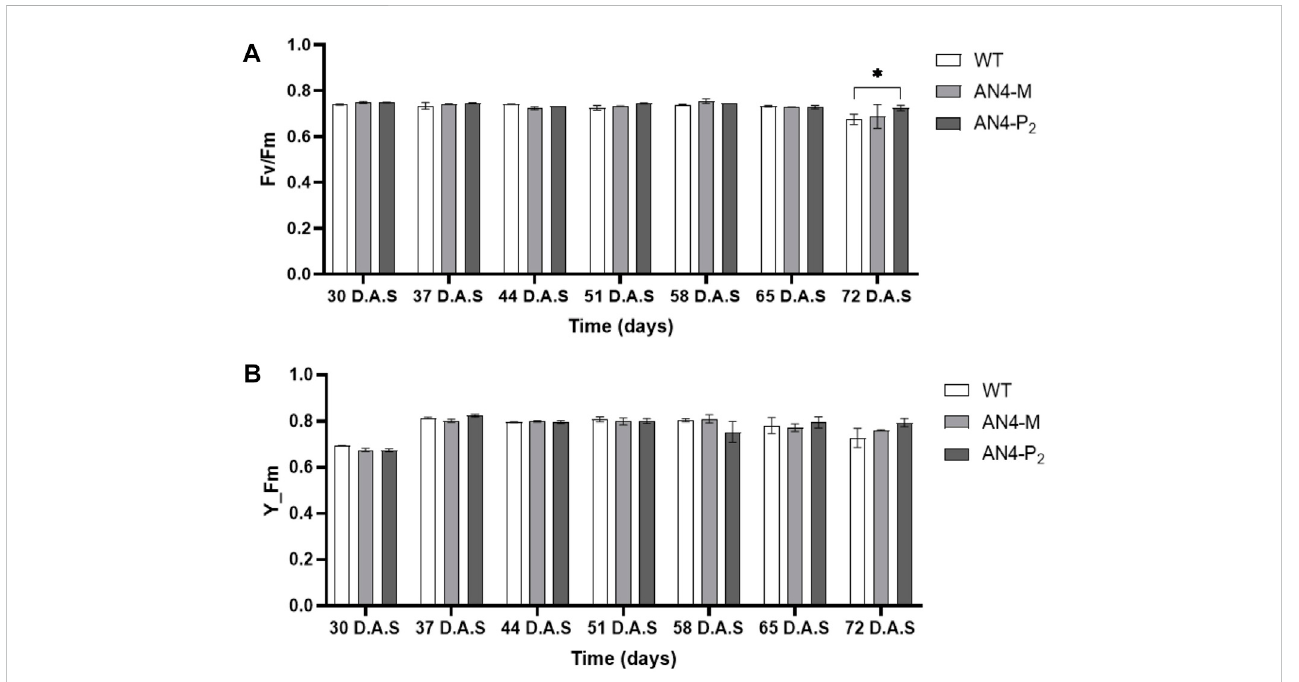
FIGURE 3 Analysis of the Fv/Fm (A) and Y_Fm (B) indices of wild type, AN4-M and AN4-P2 MicroTom along the observation period. Statistical relevance: *: p < .05; **: p < .001; ***: p < .0001. D.A.S.